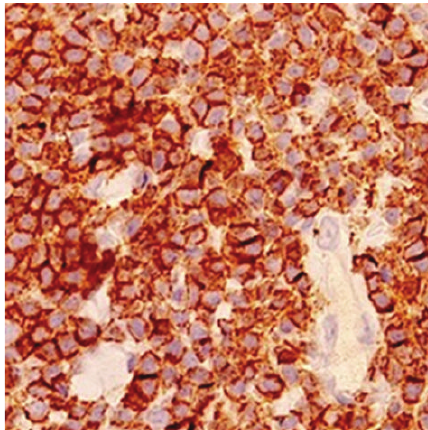
Figure 3: Positive immunohistochemical staining for CD20.